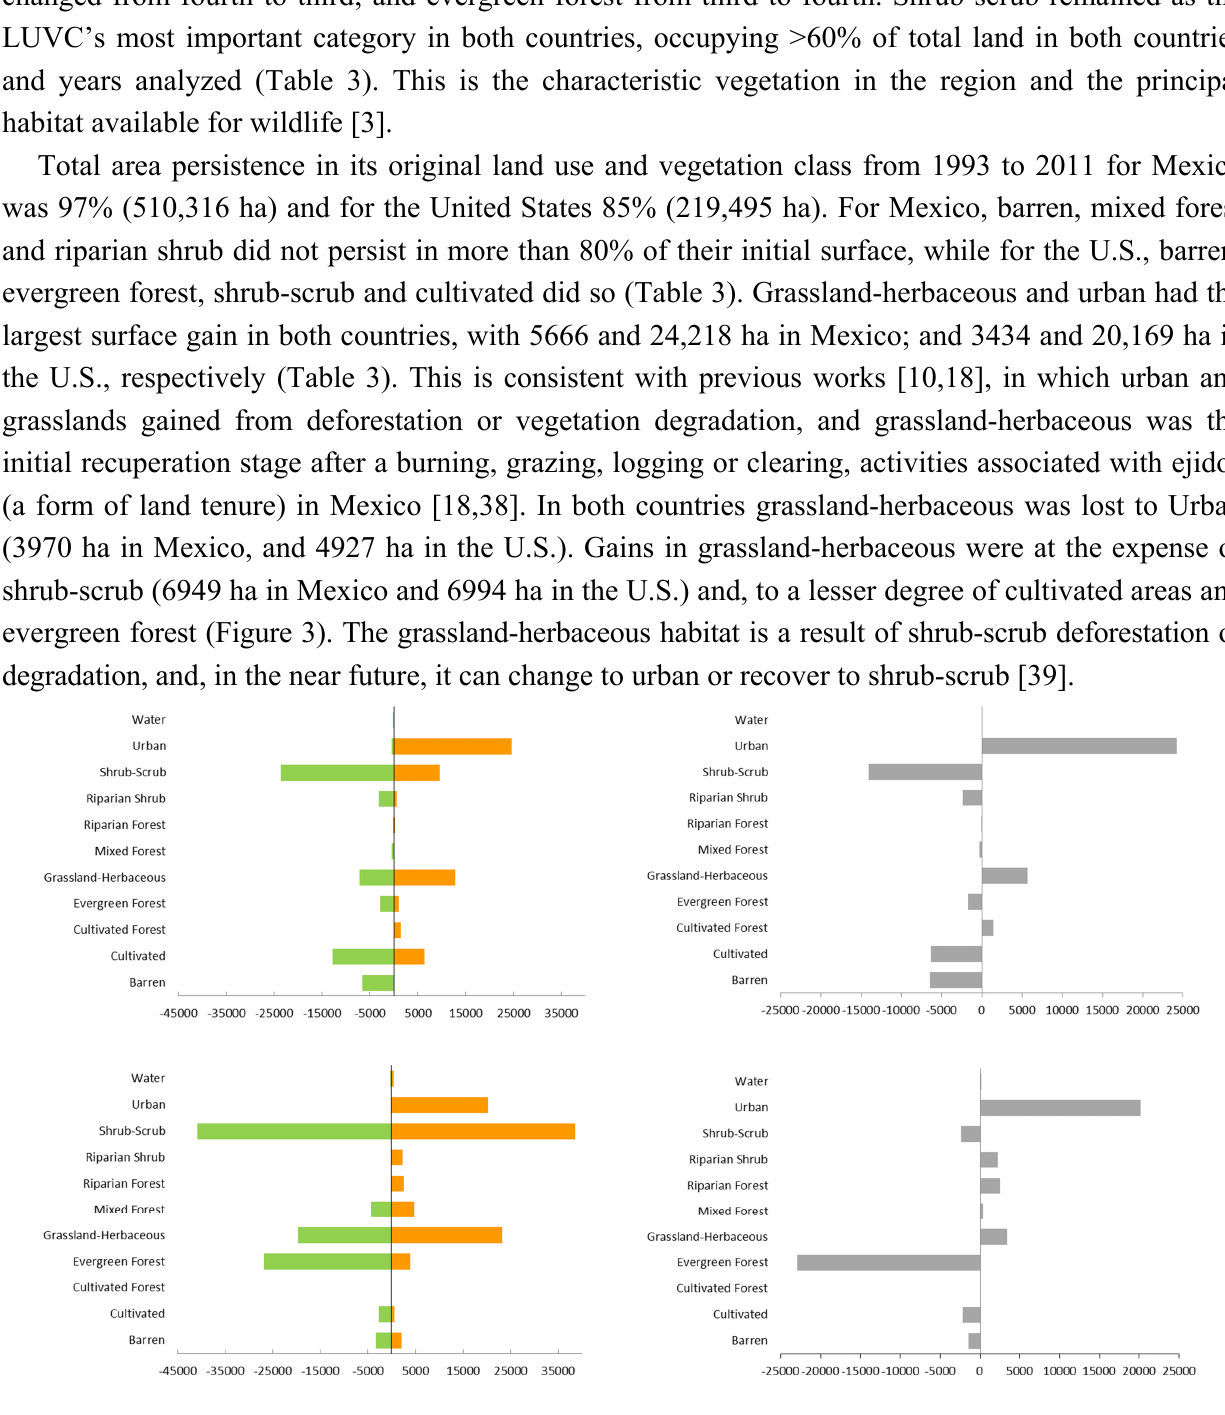
Figure 2. Gains and losses and net change per land use and vegetation cover category. Units are in hectares. ( Left ) gain and loss between 1993 and 2011 in Mexico ( top ) and between 1990 and 2011 in United States ( bottom ). ( Right ) net change in same periods and